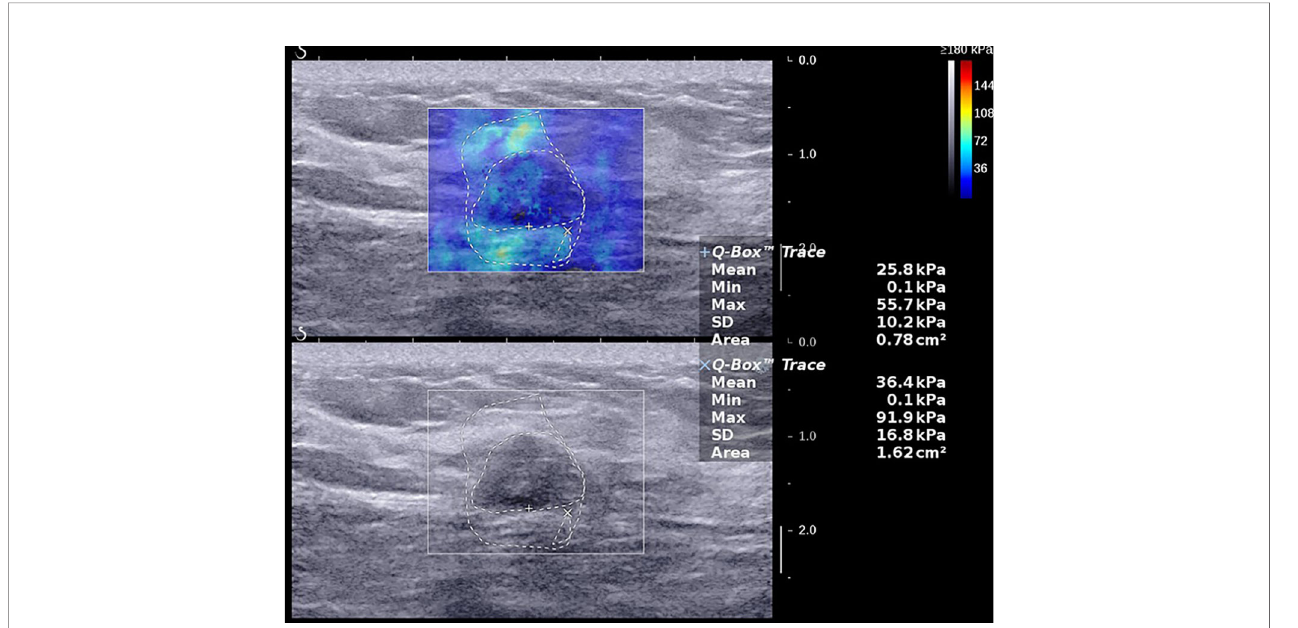
FIGURE 1 | A 47-year-old female with a 14.0-mm lesion in the right breast. A freehand ROI was drawn manually to measure areas by drawing the outline of the border of the lesion respectively in shear wave elastography and B-mode ultrasound. The SWE values of the lesion were as follows: E max , 137.9 kPa; E mean , 44.4 kPa; SD, 27.2 kPa; AR, 2.29. The lesion was invasive ductal carcinoma with the histological grade II, showing negative lymphovascular invasion and negative axillary lymph node status, ER + and PR + , HER2 - , and low expression of Ki-67,